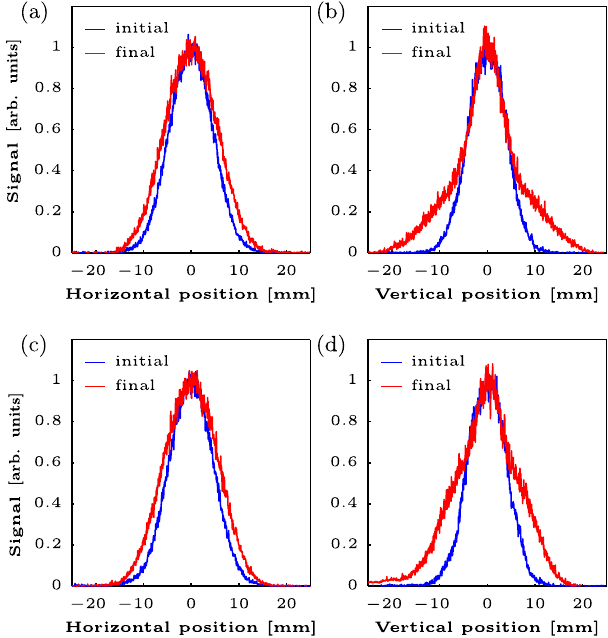
FIG. 4. Comparison between final and initial profiles at Q 6 . 104 for the horizontal (a) and the vertical plane (b). x 0 ¼ Figures (c) and (d) show the corresponding pictures for Q 6 . 129 x 0 ¼